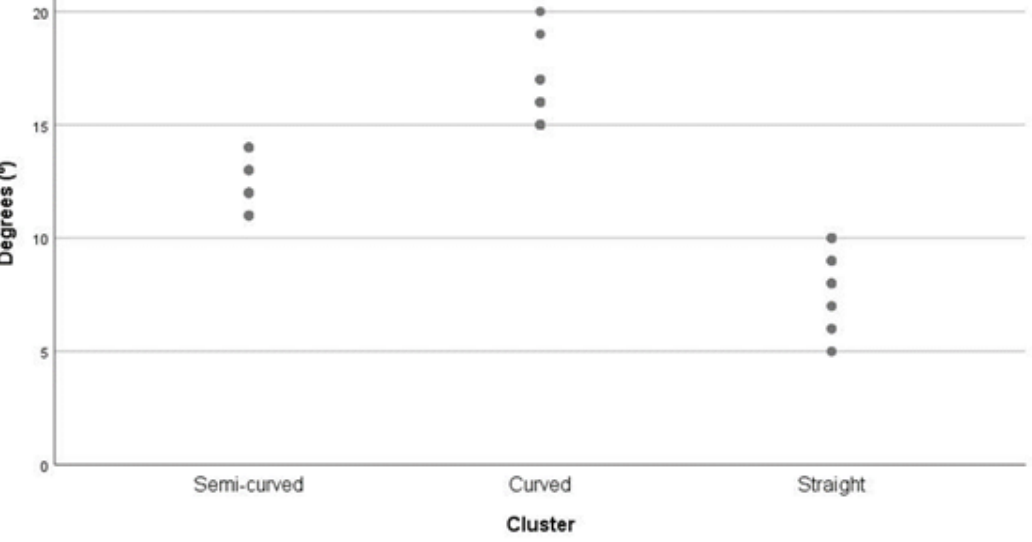
Figure 2. Cluster analysis for forefoot–rearfoot angulation.